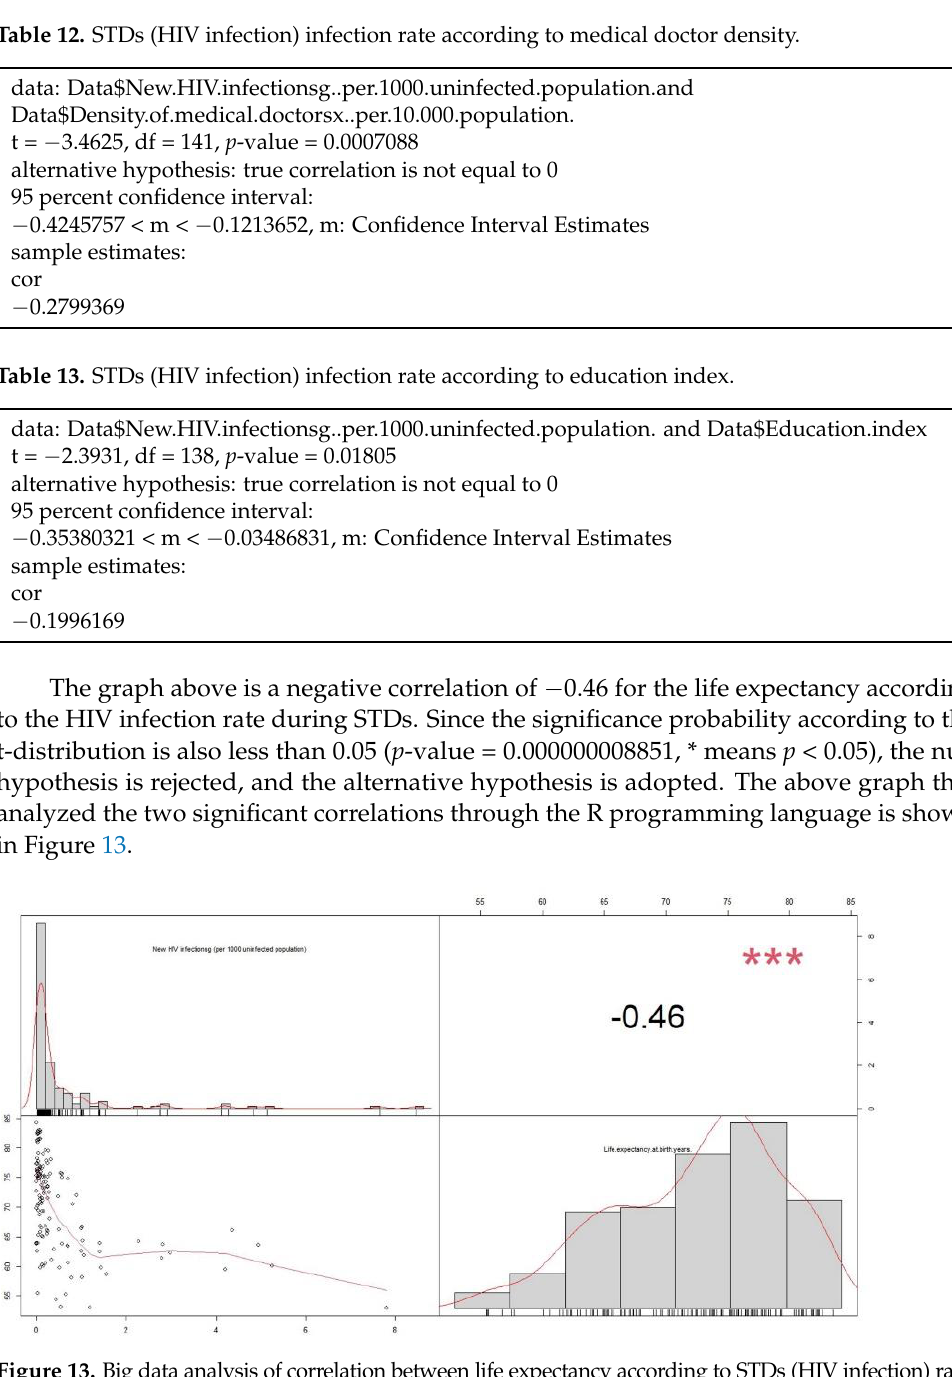
Figure 13. Big data analysis of correlation between life expectancy according to STDs (HIV infection) rate.